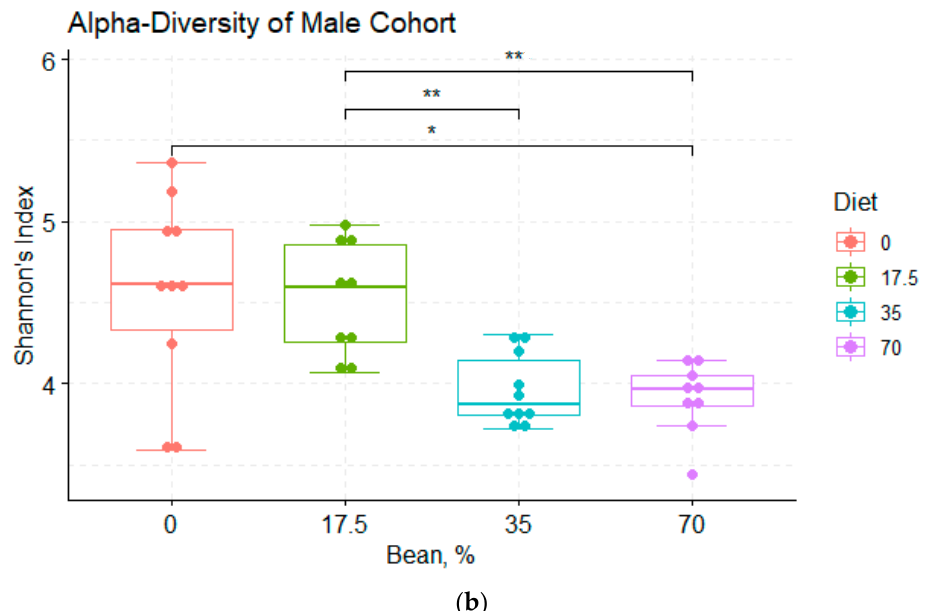
Figure 2. ( a ) Shannon’s indices of α -diversity of the female cohort. Statistically significant differences were determined by the Kruskal-Wallis test ( p -value < 0.001) with * q -value < 0.05; ** q -value < 0.01; ( b ) Shannon’s indices of α -diversity of the male cohort. Statistically significant differences were determined by the Kruskal-Wallis test ( p -value = 0.002) with * q- value < 0.05; ** q- value < 0.01.